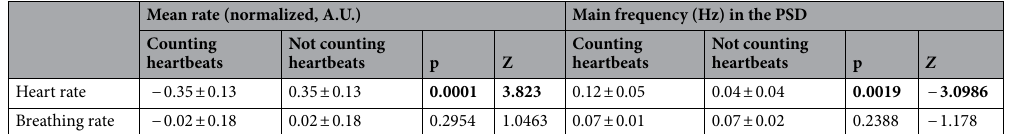
Mean rate (normalized, A.U.)